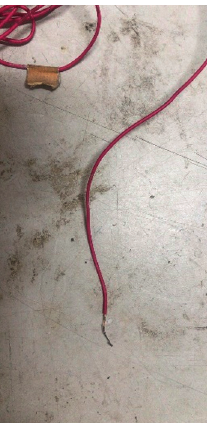
Figure 13: Thermocouple.